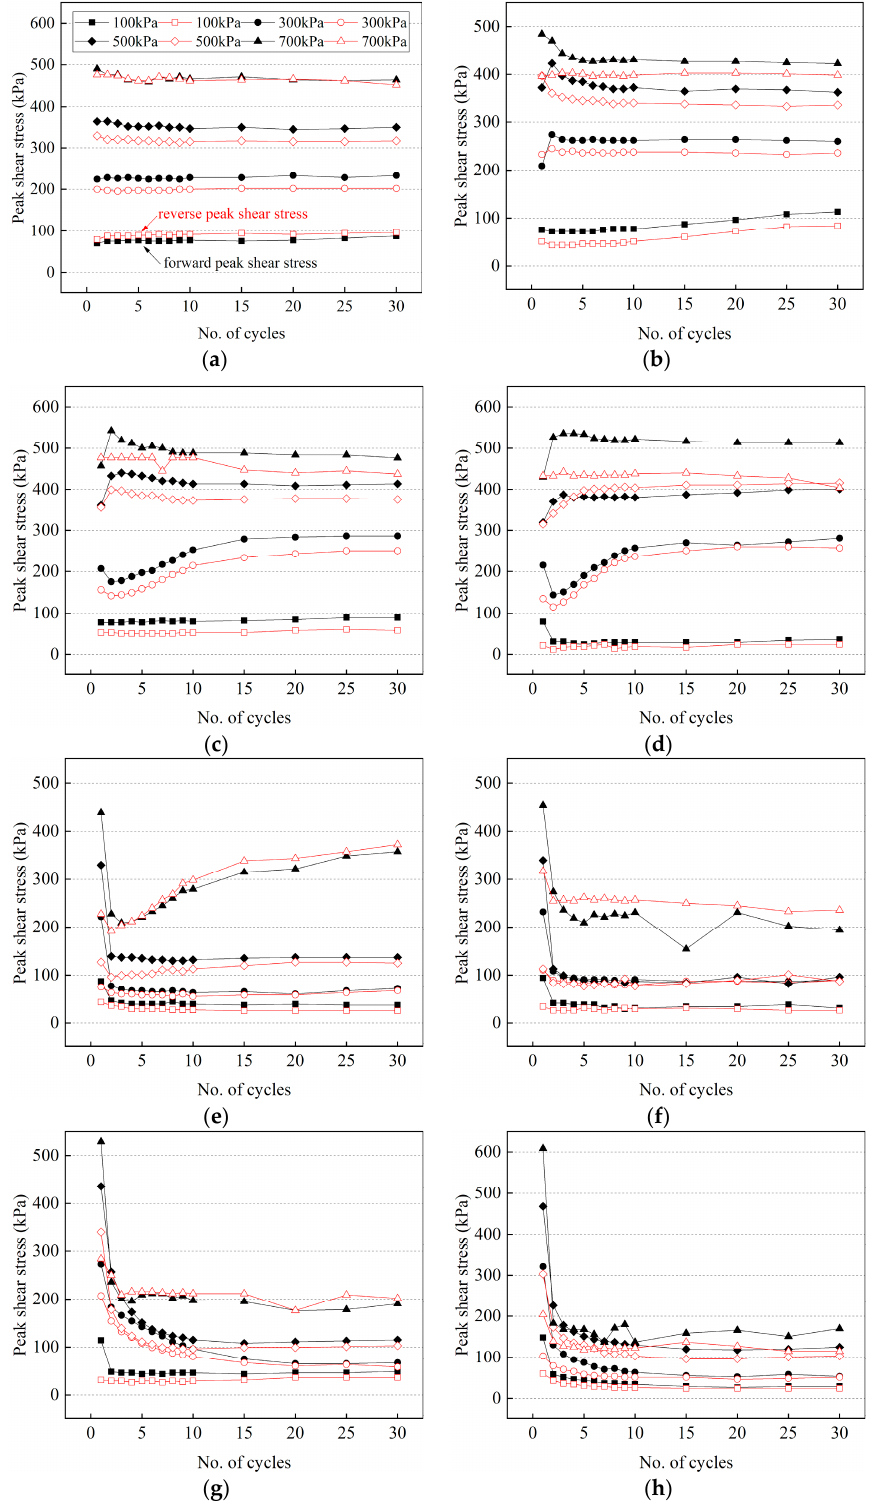
Figure 5. Peak shear stress with the number of cycles for cement-treated sand–concrete interface in various conditions. ( a ) 25 °C; ( b ) − 1 °C; ( c ) − 1.5 °C; ( d ) − 2 °C; ( e ) − 4 °C; ( f ) − 6 °C; ( g ) − 10 °C; ( h ) − 14 various conditions. ( a ) 25 ◦ C; ( b ) − 1 ◦ C; ( c ) − 1.5 ◦ C; ( d ) − 2 ◦ C; ( e ) − 4 ◦ C; ( f ) − 6 ◦ C; ( g ) − 10 ◦ C; ( h ) − 14 ◦